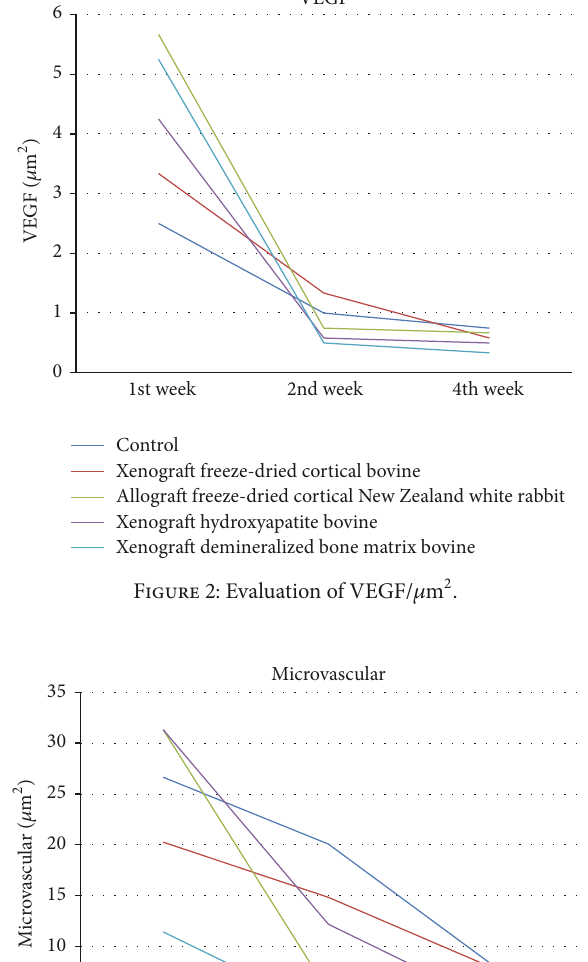
in allograft freeze-dried cortical New Zealand white